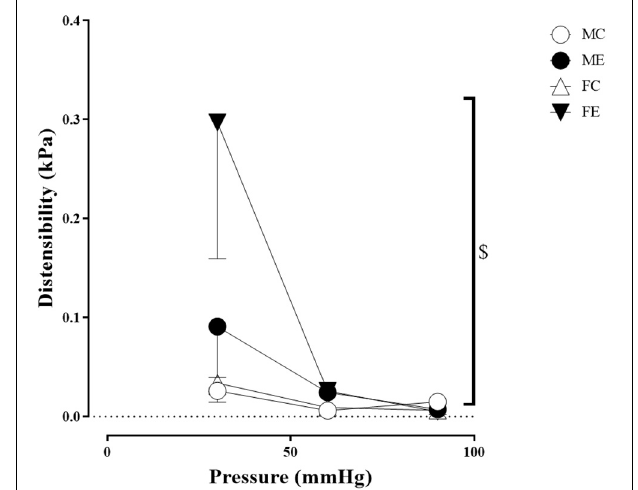
FIGURE 4 | Distensibility as a function of intraluminal pressure measured under passive conditions of the gracilis muscle arterioles from the MC, ME, FC, and FE animals. Distensibility increased in the FE rats compared with the FC rats. The data are expressed as the mean (SEM) values. The significance levels of the two-way ANOVA and Tukey’s post hoc tests between the four groups are shown. $ P < 0.05 FC vs.